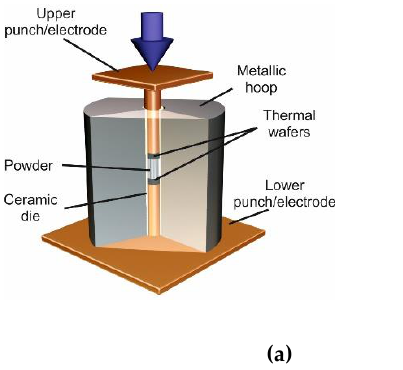
Figure 2. ( a ) Sketch of punches and die used in medium frequency electrical resistance sintering (MF- (MF-ERS) experiences, and ( b ) resistivity vs. compaction pressure of WC6Co ERS) experiences, and ( b ) resistivity vs. compaction pressure of WC6Co powder.